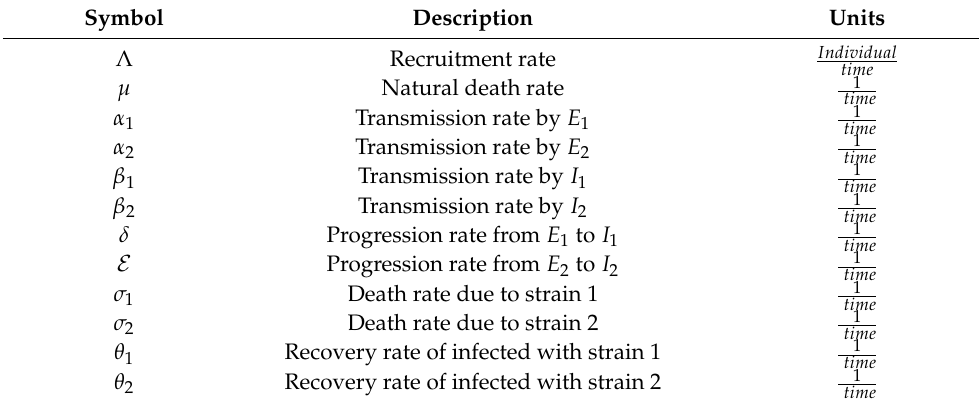
Table 1. Parameters of the COVID-19 model with two strains.